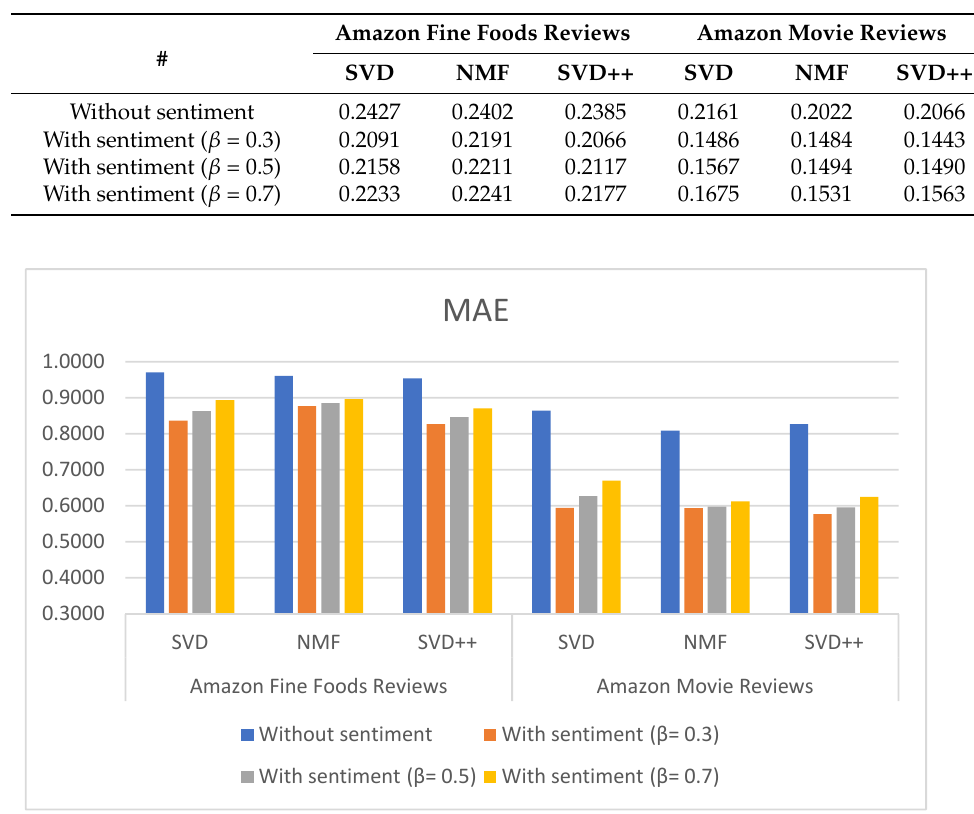
Figure 6. MAE measures comparison for different types of method and datasets using L-CNN sentiment model. Table 4. RMSE values without and with L-CNN sentiment analysis model.